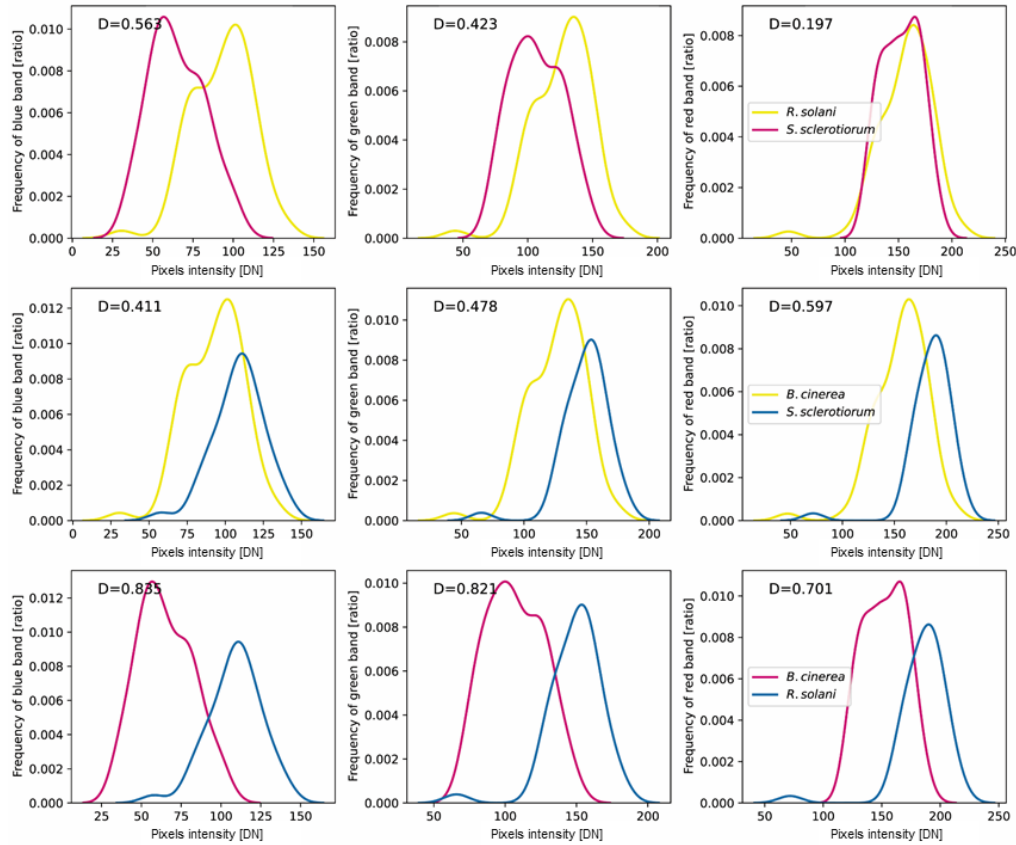
Figure 5. Distinguishing between three species of fungi based on the intensity of pixels in three spectral bands from an RGB images.